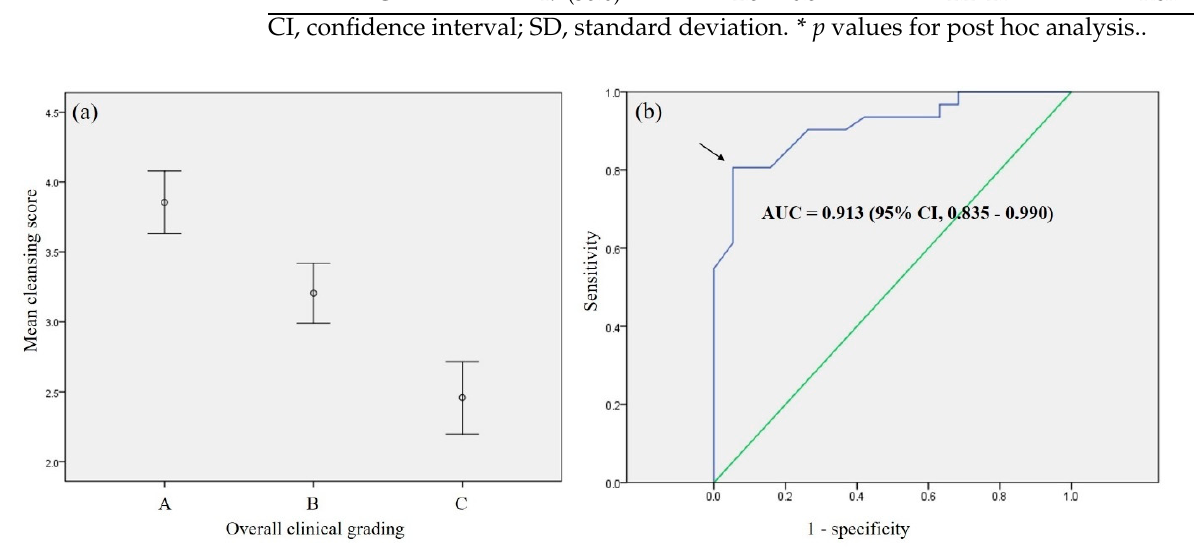
Table 3. Average cleansing scores according to overall clinical grading of validation cases.